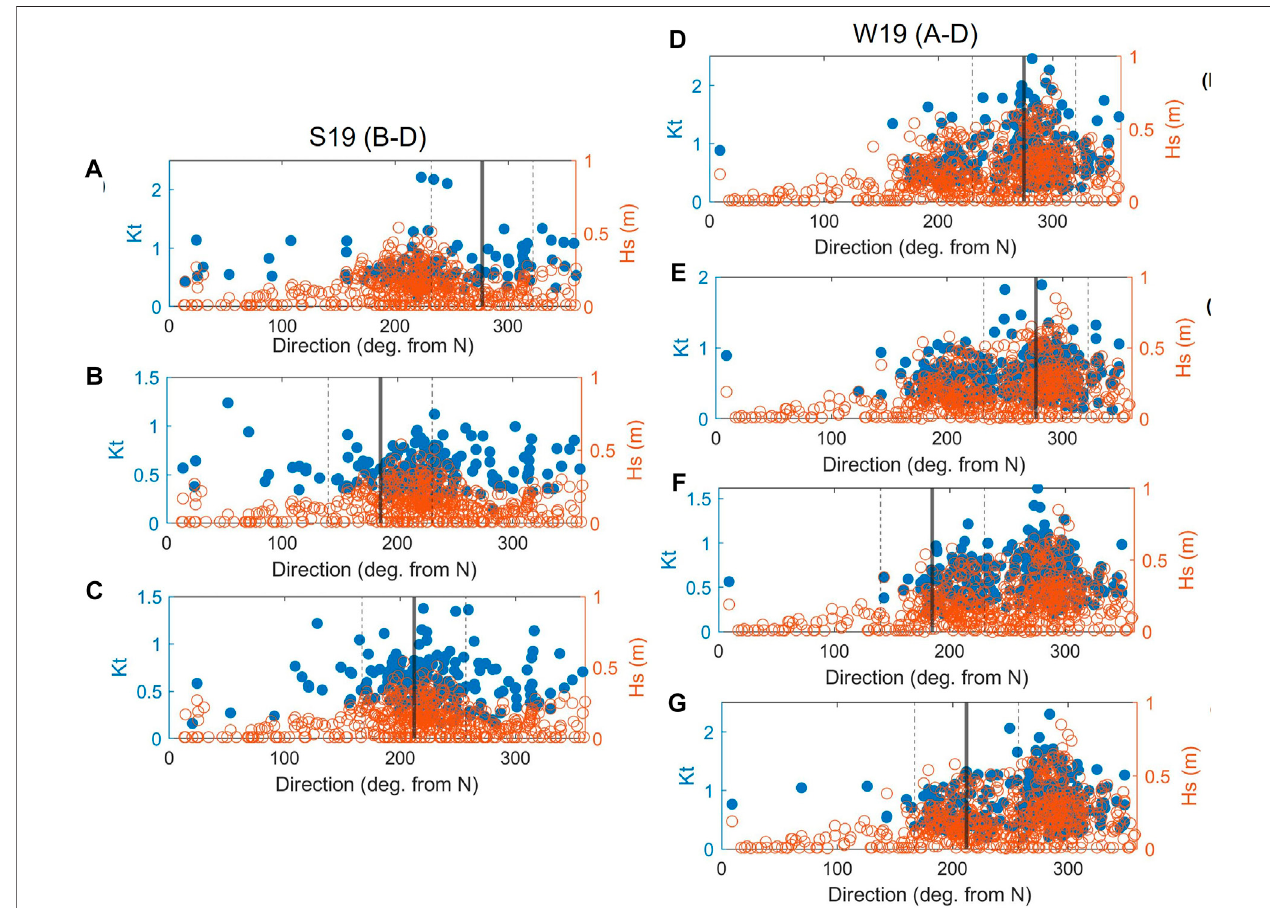
FIGURE 5 | Incident wave direction and signi fi cant wave height (open red circle) from offshore ADCP and transmission coef fi cient ( K t ) ( fi lled blue circle) during S19 (A – C) and W19 (D – G) and at Site A (D) , B (A,E) , C (B,F) , and D (C,G) . Direction of structure perpendicular is indicated with vertical lines and have a ± 45 o range. Direction of approach does not appear to have a meaningful impact on transmission coef fi